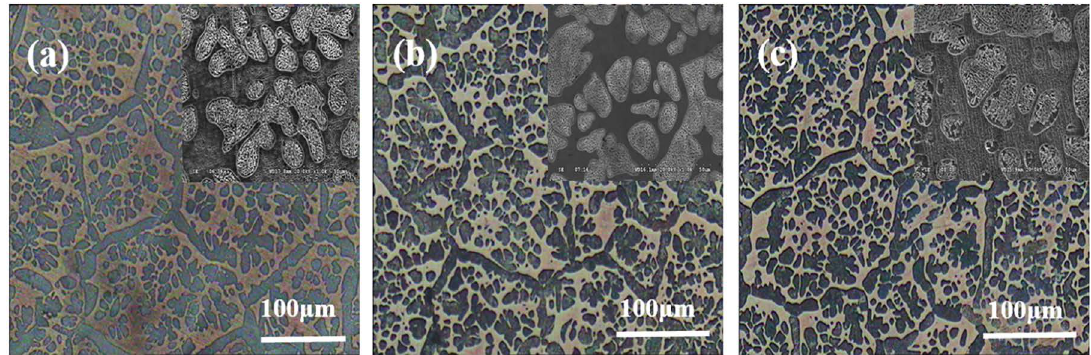
Figure 1. Microstructure of aluminum brass alloy with and without EPT (a) Original sample (b) 500 V (c) 700 V